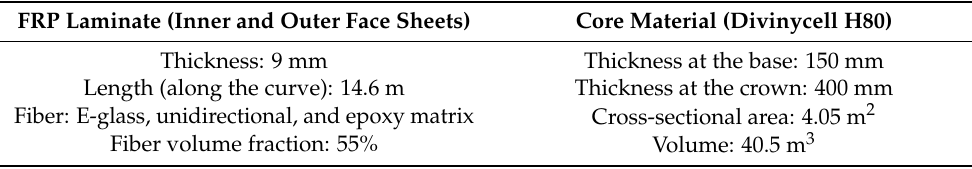
Table 3. Results of the FRP culvert design.